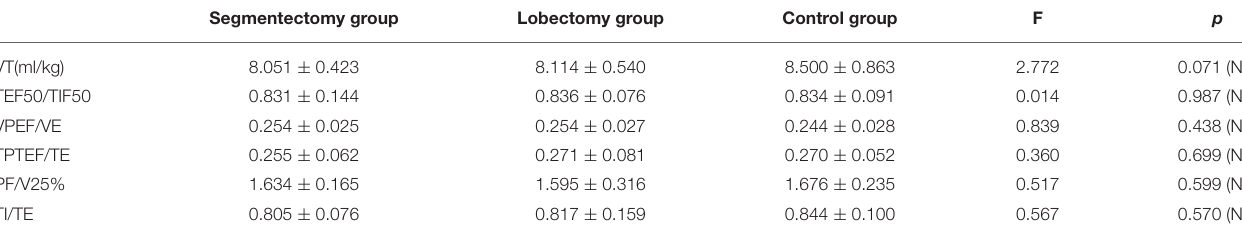
TABLE 4 | Comparison of pulmonary function test results in segmentectomy group, lobectomy group and control group (2 years after